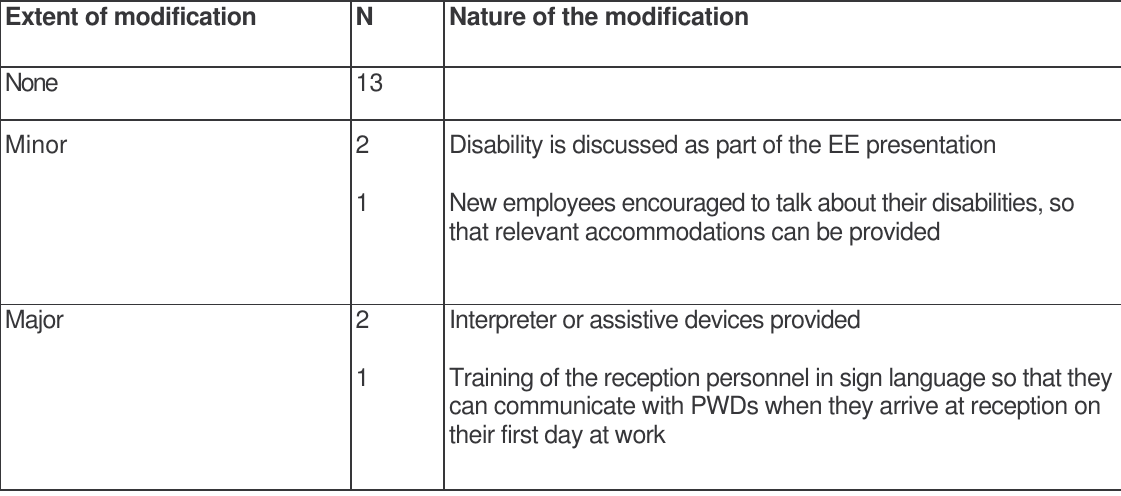
Table 5: Induction and orientation of new staff members Extent of